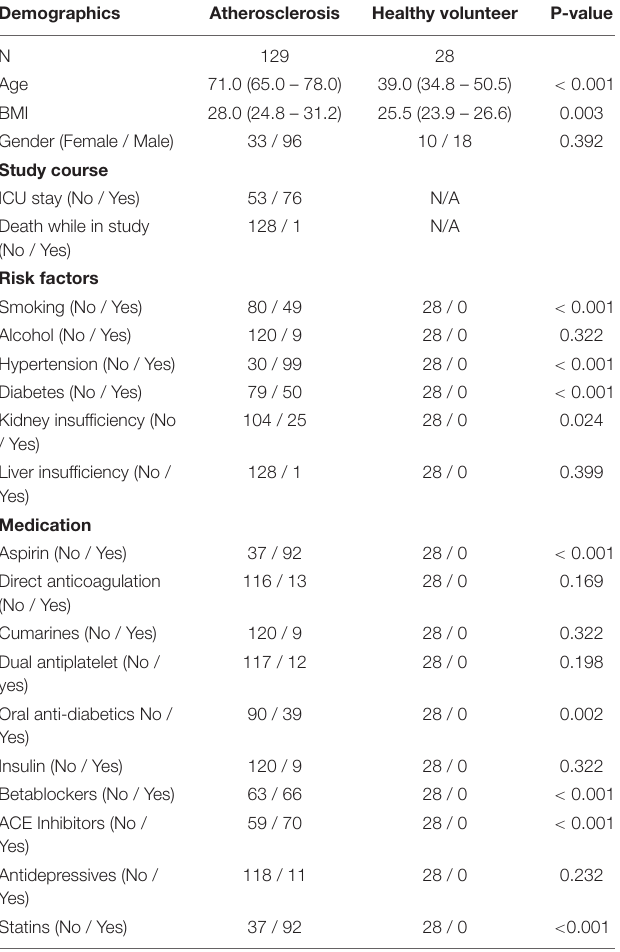
TABLE 2 | Overview of the demographic, risk factors and medication of all participants in this